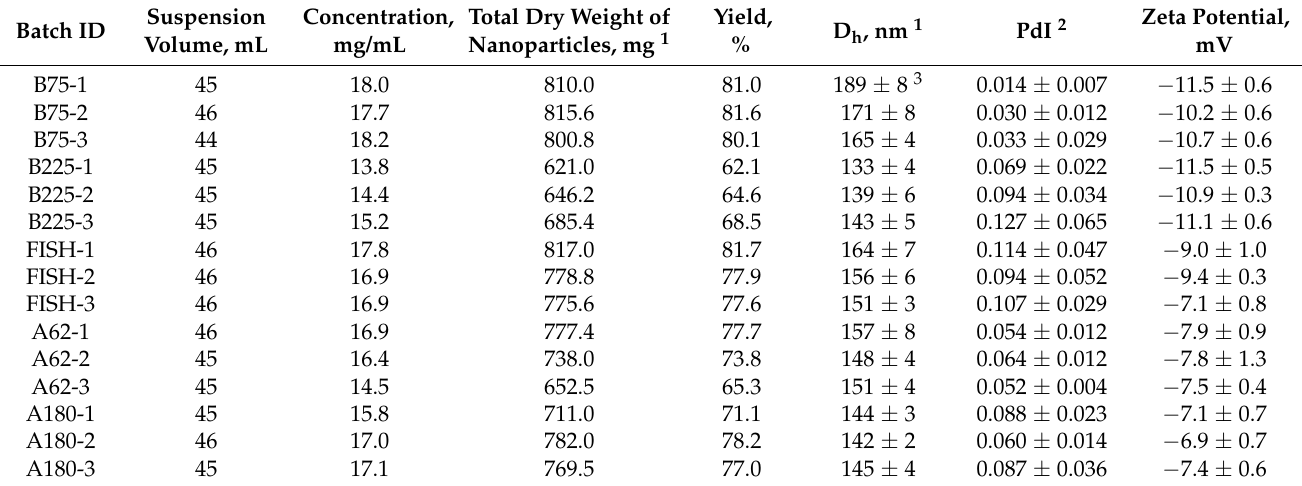
Table 1. Properties of gelatin nanoparticles prepared from different gelatins.